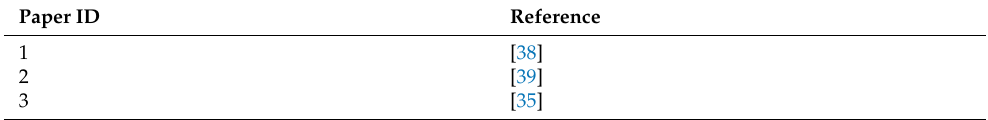
Table 6. Reference papers to validate the output of the prognostic algorithms in the GPF.